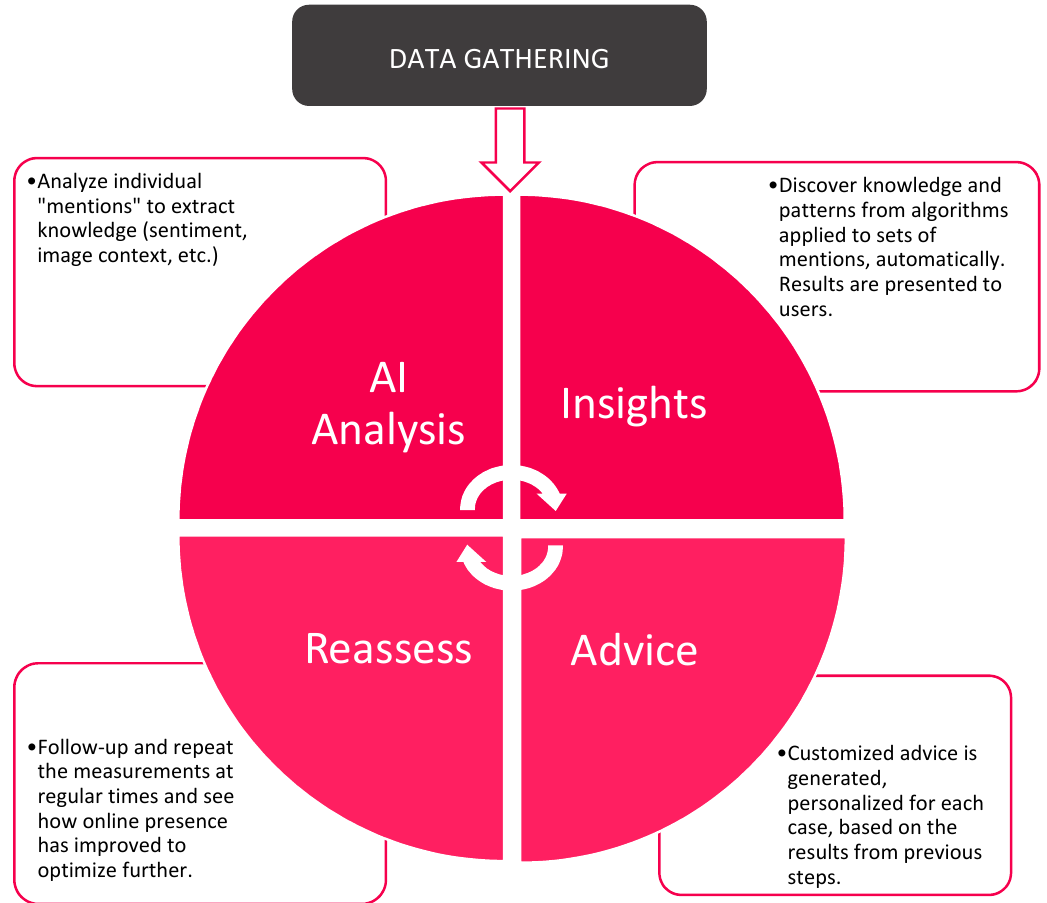
Figure 3. Social intelligence advisor processes.